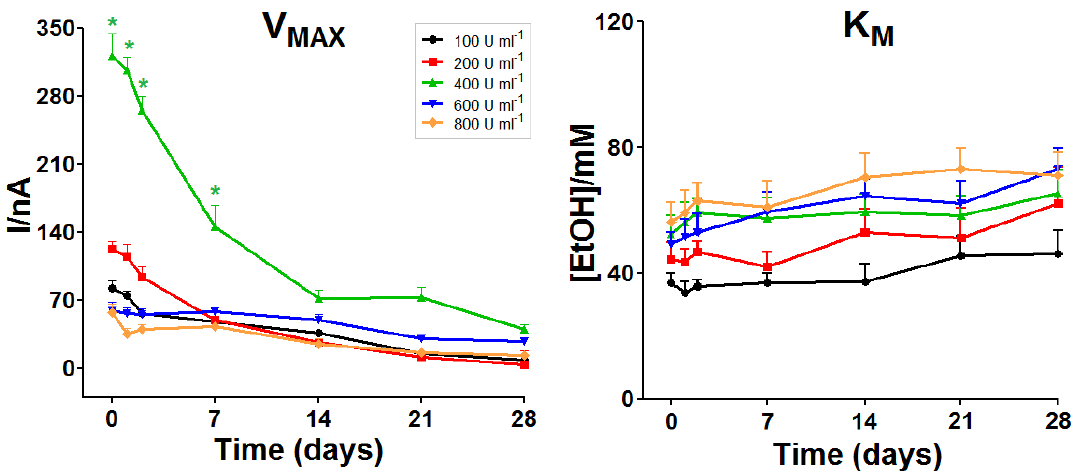
Figure 2. In-vitro stability study: evolution of the enzyme kinetic parameters, I K , over a 28-day monitoring period, for biosensors fabricated from different enzyme M loading solutions ( n = 4 for each group). * p < 0.05 vs. other groups.